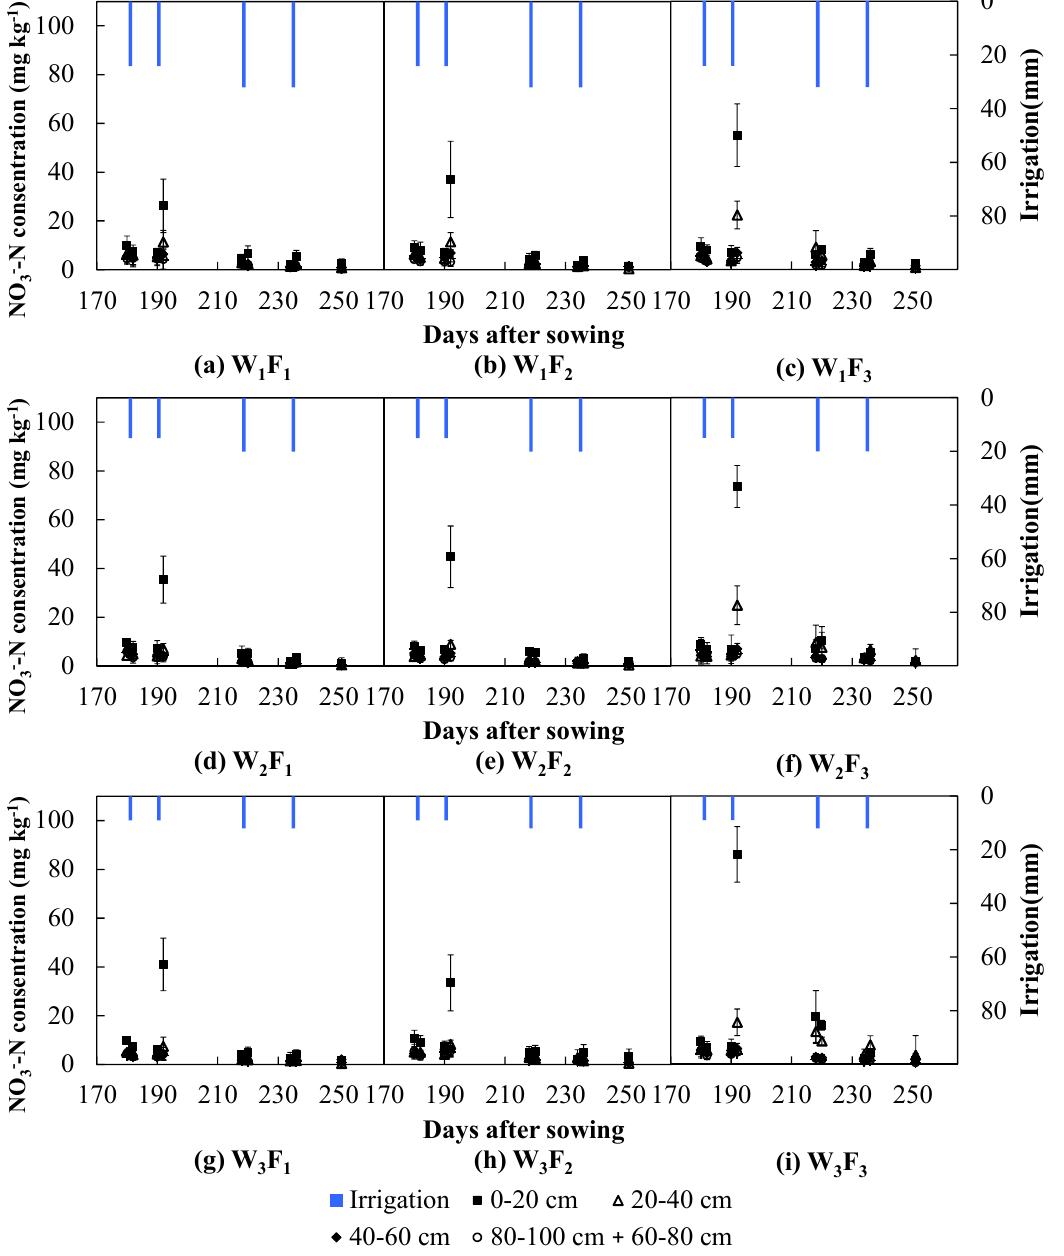
Figure 4. Temporal variation in the NO 3 − -N concentration (mg·kg − 1 ) during the 2012 winter wheat growing season for nine treatments: W 1 , W 2 and W 3 , irrigations scheduled according to 0.8, 0.5 and 0.3 cumulative evaporation of 20-cm-diameter pan (E), respectively; F 1 : N application at 120 kg·ha − 1 ; F 2 : N application at 140 kg·ha − 1 ; and F 3 : N application at 190 kg·ha − 1